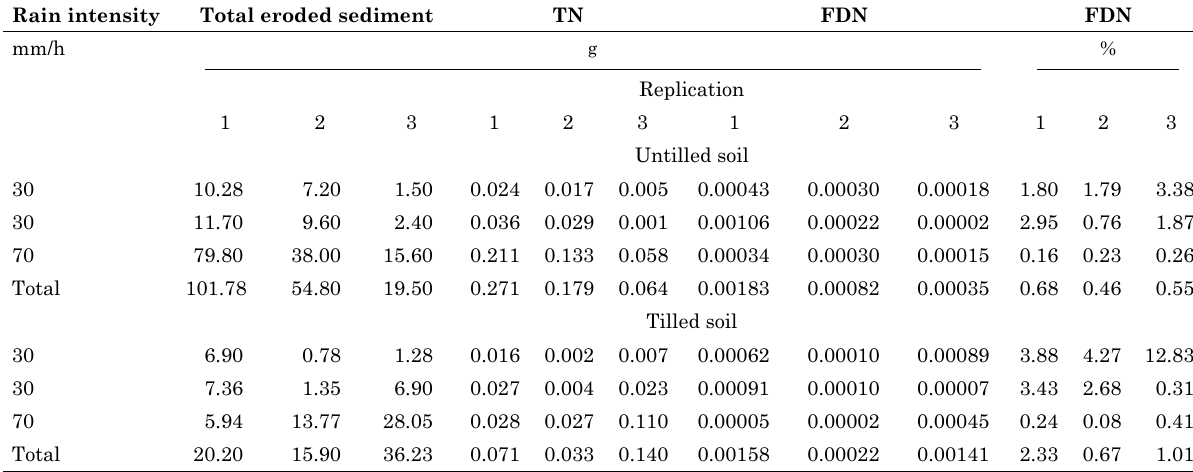
table 3. total eroded sediment, quantity of total nitrogen (tN) and fertilizer-derived N (fdN) and percentage of fdN in relation to tN (%fdN) in each treatment, at the end of each rain, in Untilled and tilled soils rain